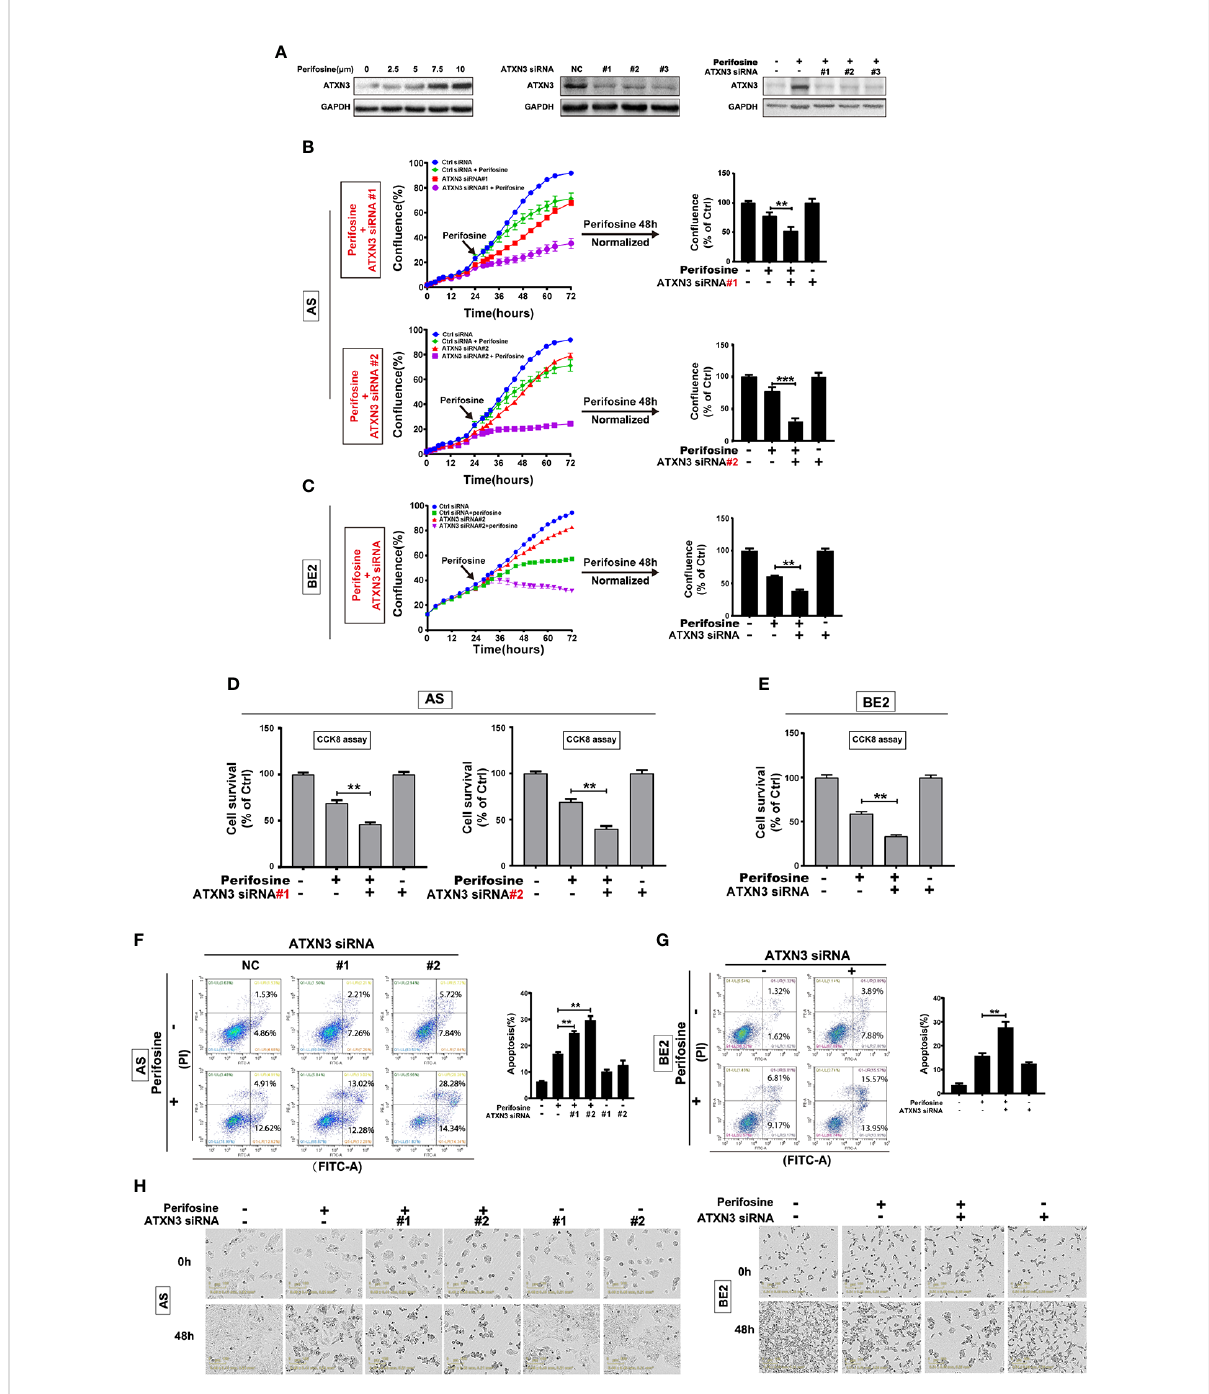
FIGURE 1 Downregulation of ATXN3 promoted perifosine-induced cell death in NB cells. AS cells were treated with different concentrations of perifosine (2.5, 5, 7.5, and 10 m M) for 24 h, or transfected with ATXN3 siRNA (#1, #2, #3, and control) for 48 h, or transfected with ATXN3 siRNA (#1, #2, and #3) for 16 h followed by 24 h treatment of perifosine. (A) The expression of ATXN3 were detected by Western blot; (B, C) AS cells were transfected with ATXN3 siRNAs (#1, #2), and BE2 cells were transfected with ATXN3 siRNA2 (marked as ATXN3 siRNA) for 16 h, followed by 48 h treatment of perifosine: Cell con fl uence was dynamically detected by IncuCyte Zoom and analyzed at the end of experiment; (D, E) Cell survival was detected by CCK8 assay; (F, G) cell apoptosis was detected by Annexin V/PI fl ow cytometry; (H) The images of AS and BE2 cells with ATXN3 siRNAs transfection and perifosine treatment at 0 h and 48 h were recorded. Bar, SD, **P < 0.01, ATXN3 siRNAs + perifosine vs. control siRNA + perifosine; ***P < 0.001, ATXN3 siRNA #2 + perfosine vs. control siRNA +